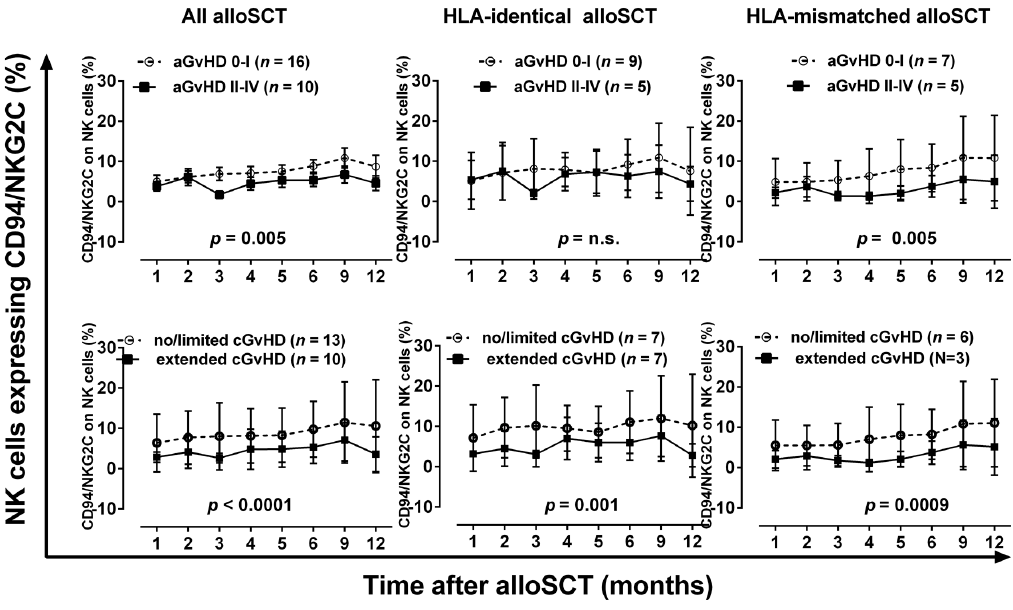
Figure 1. The proportions of NK cells expressing CD94/NKG2C during the course of the first